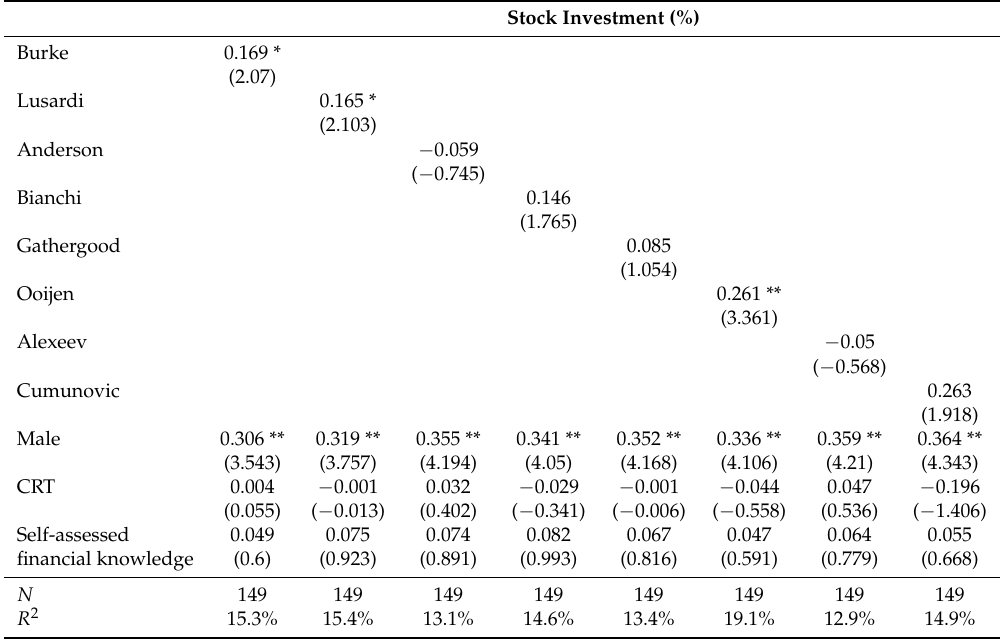
Table 12. External validity of the original financial literacy measures regarding stock investment in the stock market task.